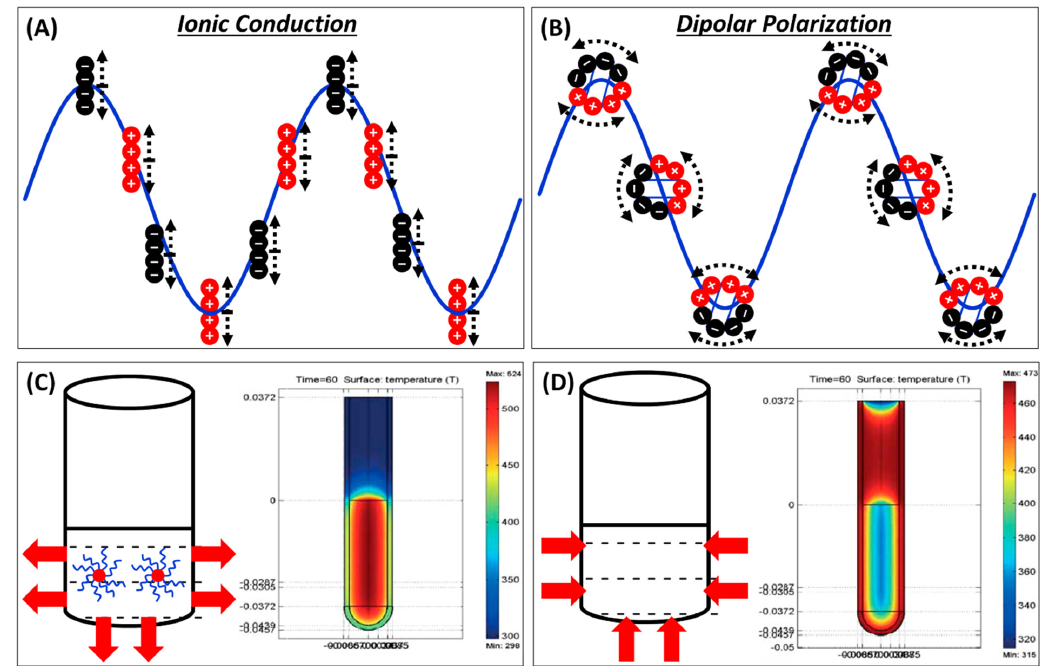
Figure 2. ( A , B ) Representation of ionic conduction and dipolar polarization mechanisms under µwH; heating comparisons between µwH ( C ), and CvH ( D ); µwH leads in a better overall heating and temperature control than CvH. Adapted with permission from Springer Science and Business Media B.V.